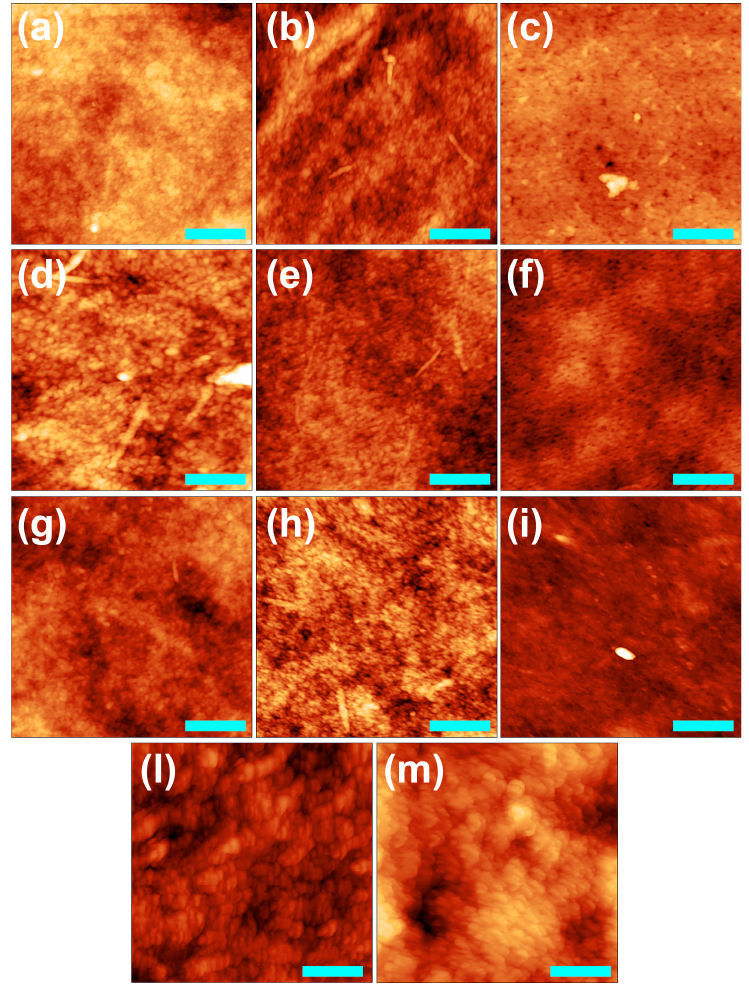
Figure 4. AFM images of 200 ( a – c ), 500, ( d – f , l , m ) and 1000 µm ( g – i ) CA membranes prepared by the basic procedure ( a , d , g ) or in situ addition of salt ( b , e , h ) or SAB ( c , f , i ), and with the addition of P127 using the basic procedure ( l ) and SAB ( m ). The film applicator speed was 5 mm/s. Scale bar = 500 nm and false color = 70 nm. Table 1. Roughness (Rms) values of the membranes as a function of preparation conditions and thickness (scanning square areas of 2 µm × 2 µm).